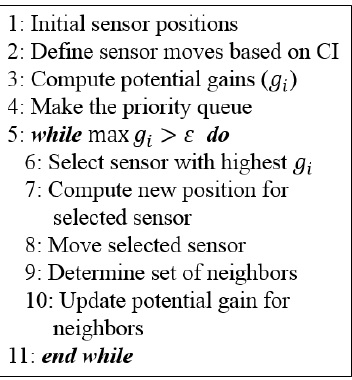
Figure 1: Context-aware sensor network deployment framework